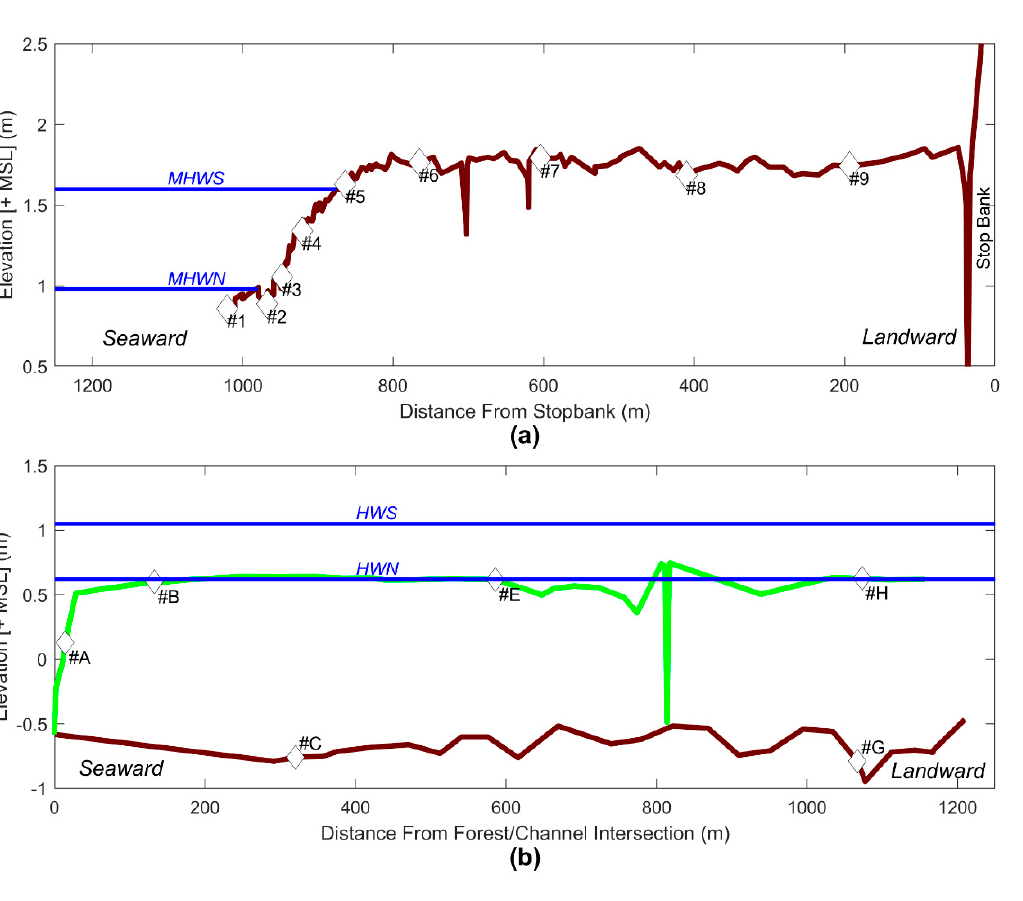
Figure 3. ( a ) The elevation profile along the instrument transect in the Firth of Thames. Mean High Water Spring (MHWS) and Mean High Water Neap (MHWN) are noted. The main forest is higher than normal tidal levels and therefore no drainage channels have been scoured by tidal water flow; ( b ) the Tauranga RTK survey of transect through central mangrove forest (green) and thalweg (brown). High Water Spring (HWS) and High Water Neap (HWN) are marked (blue). The semi-diurnal tidally-driven flow through the forest is responsible for channelization at the site.